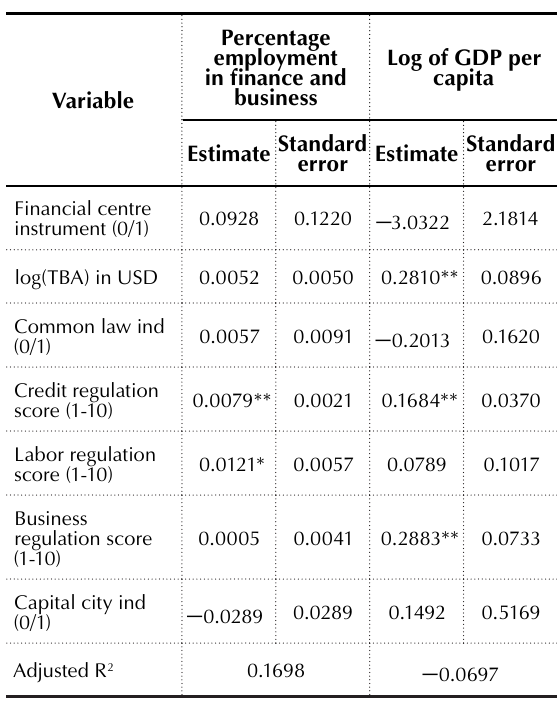
Table 2. The effect of financial centre status and other selected explanatory factors on GDP per capita and percentage of jobs in finance and business